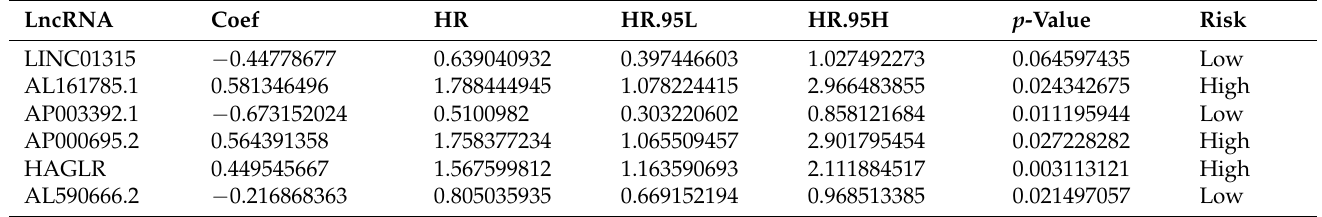
Figure 1. Workflow of the prognostic risk model analysis. Table 2. The risk model of six pyroptosis-related lncRNAs with prognostic values in GC.